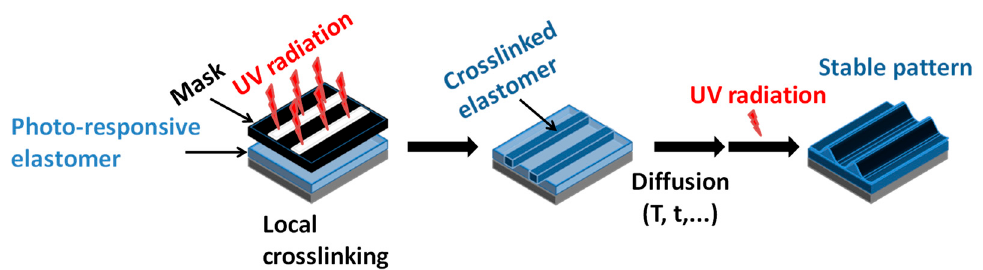
Figure 1. Photo-adjustable patterns with polymers modified with coumarin. Reproduced from [81] with permission from the Royal Society of